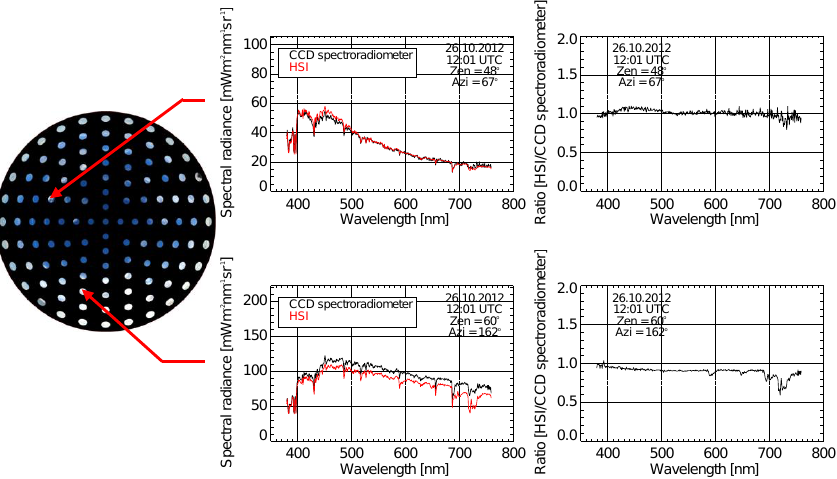
Figure 9. Spectral radiance measured on 26 October 2012 at 12:01UTC by the CCD spectroradiometer and the HSI system for the scanning points with the azimuth and zenith angle of 67 ◦ and 48 ◦ (upper panel) and for the azimuth and zenith angle of 162 ◦ and 60 ◦ (lower panel). The ratio between the measured and computed spectral radiance is shown on the right. The agreement is considered to be satisfactory. Table 2. The MBD and RMSD of the spectral sky radiance measured by the HSI system and the CCD spectroradiometer on various days corresponding to the sky conditions shown in Table 1. MBD